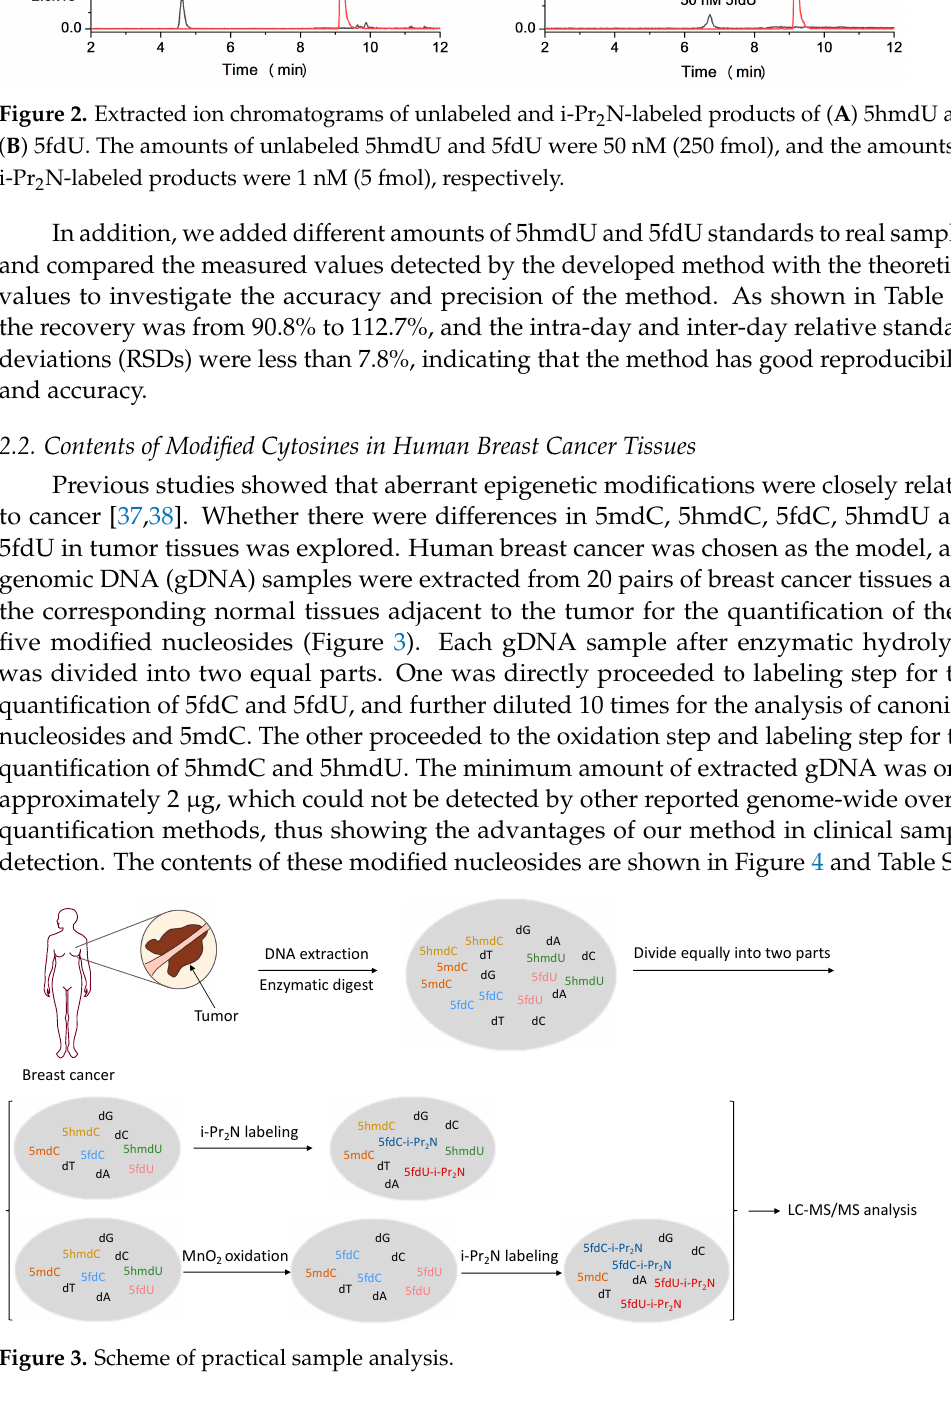
Figure 4. Quantification of ( A ) 5mdC, (B) 5hmdC, ( C ) 5fdC, ( D ) 5hmdU and ( E ) 5fdU in breast cancer tissues. * p < 0.1; ** p < 0.05; *** p < 0.01. The quantification results showed that the contents of 5mdC ( p < 0.1), 5hmdC ( p < 0.01) and 5fdC ( p < 0.1) decreased, while the contents of 5hmdU ( p < 0.05) and 5fdU ( p < 0.01) increased in tumor tissues compared to normal tissues adjacent to the tumor in gen-